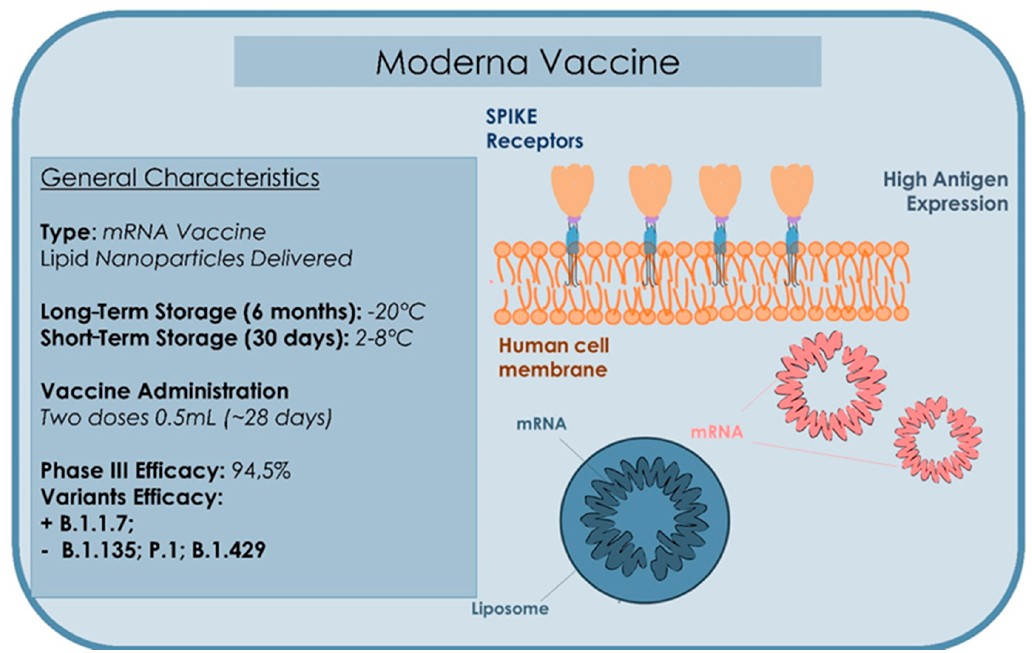
Figure 6. Summary of the type, storage administration, and efficacy characteristics of the Moderna Vaccine.